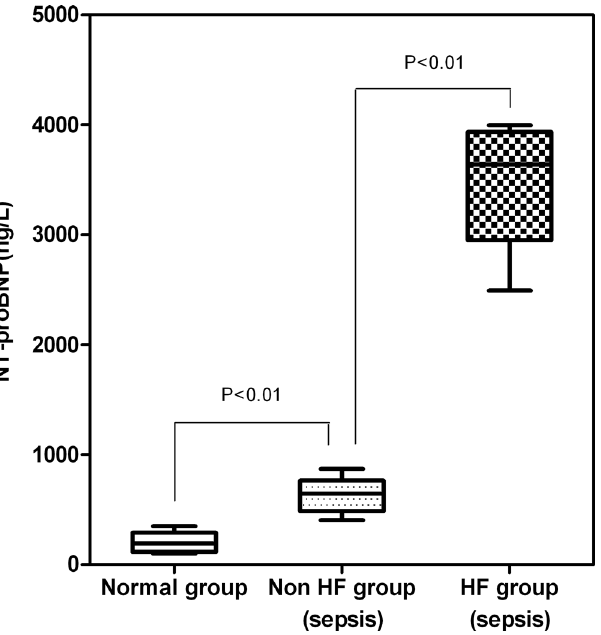
significant ( χ 2 = 41.87, P < 0.001).